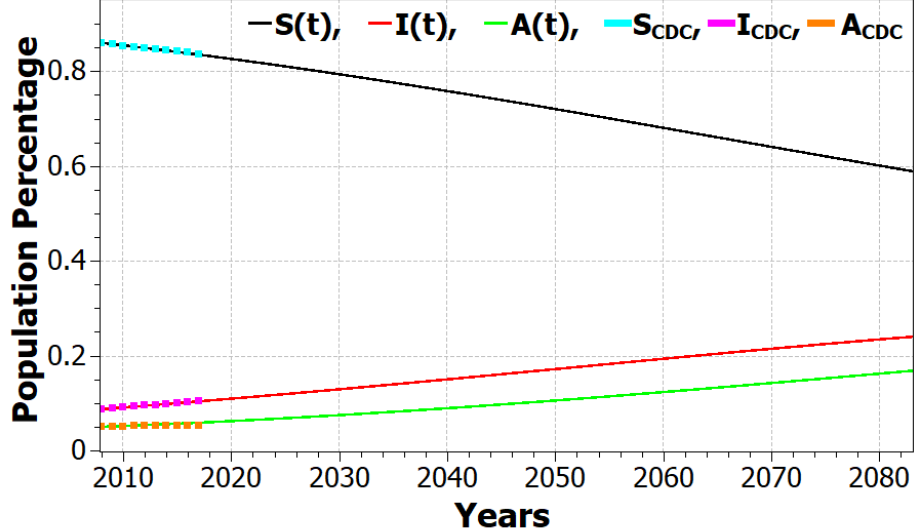
Figure 1. CDC data and SIA model projections for the susceptible, S ( t ); infected, I ( t ); and AIDS, A ( t ), populations as a function of time. The dashed lines are the recorded values from the CDC while the solid lines are the results of our SIA model. Table 2. List of SIA model parameters a